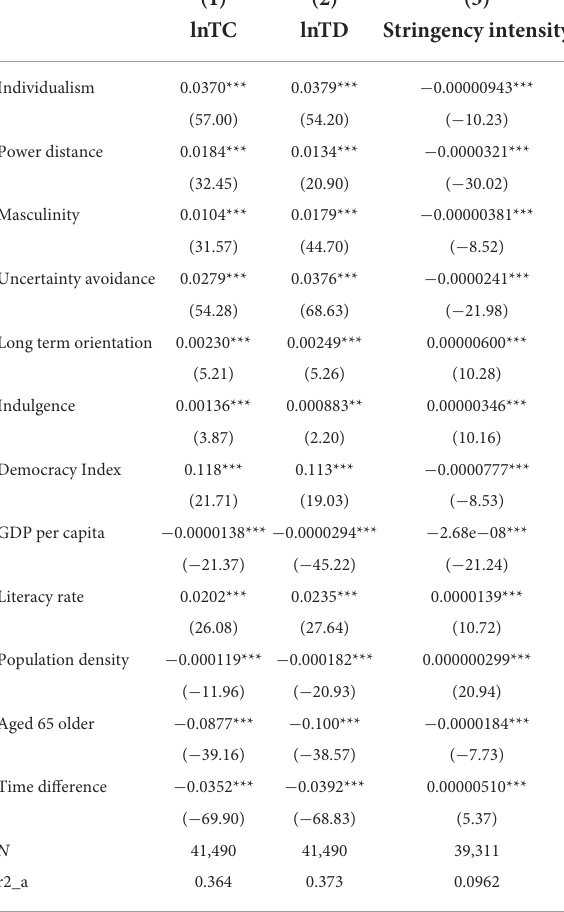
TABLE 9 Mediating effect of stringency